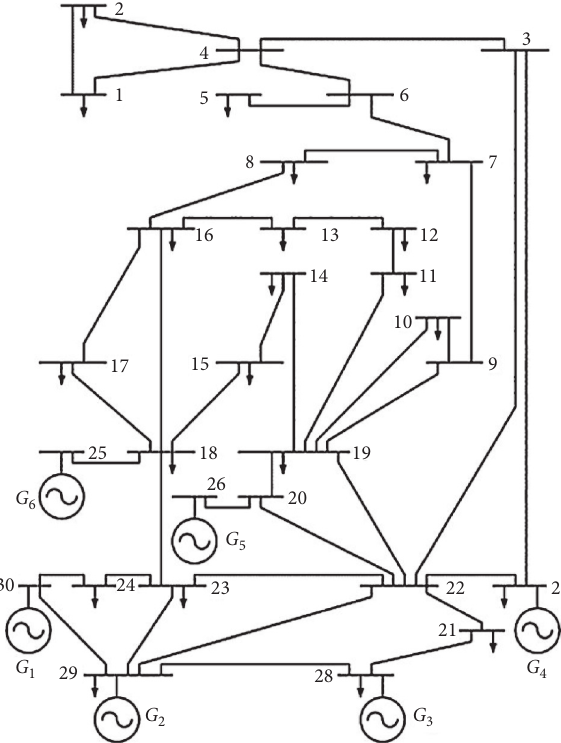
Figure 5: IEEE system line diagram of 30-bus 6 generators. Table 1: Generator limits, fuel cost coefficients, and emission coefficients of the IEEE 30-bus system.